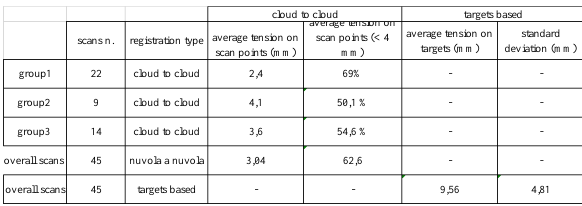
Table 4. Comparison of residuals among different groups of scans and different types of registration.